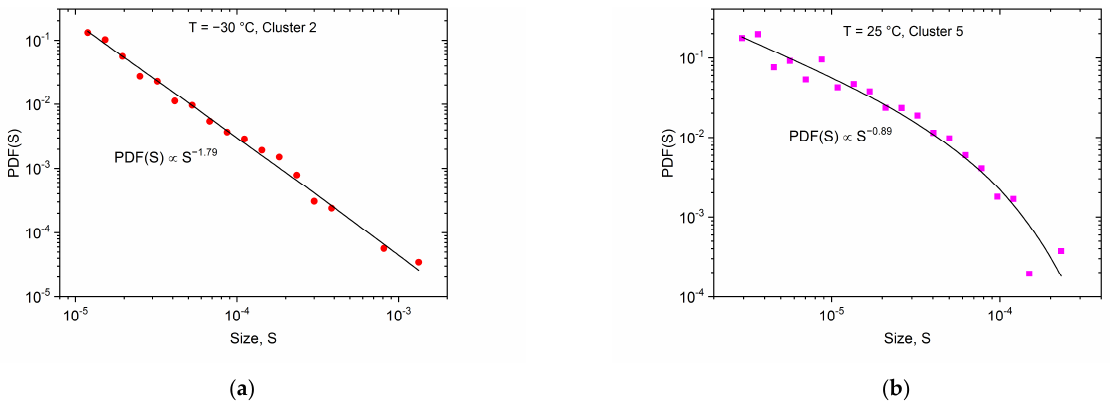
Figure 10. Probability density functions of the avalanche sizes for Cluster 2 ( a ) and for Cluster 5 ( b ).